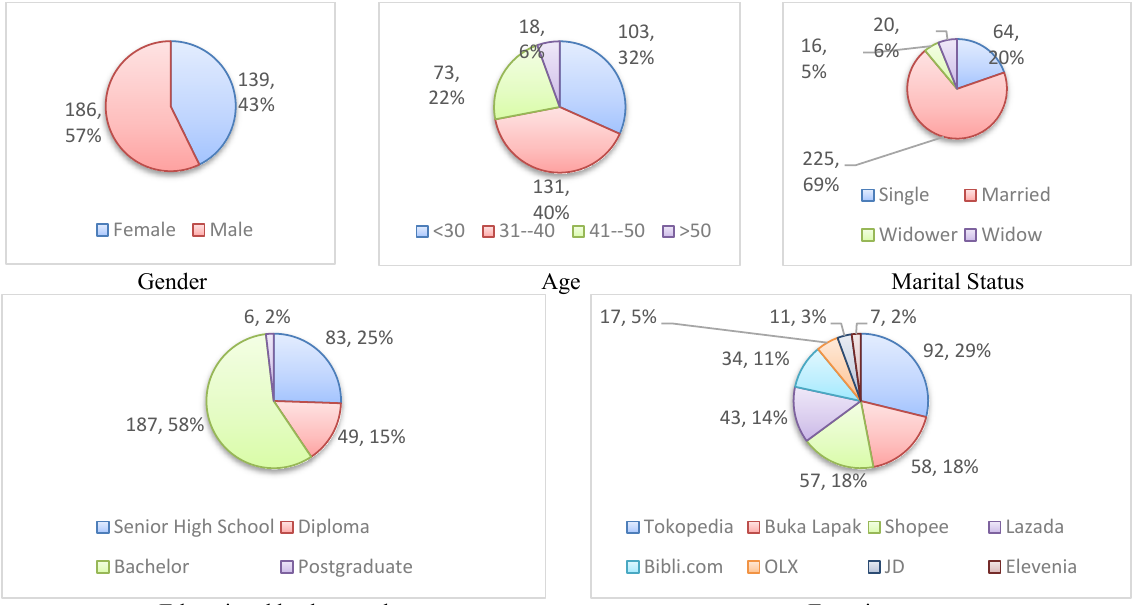
Fig. 1. Results of Demography Profile of Respondents